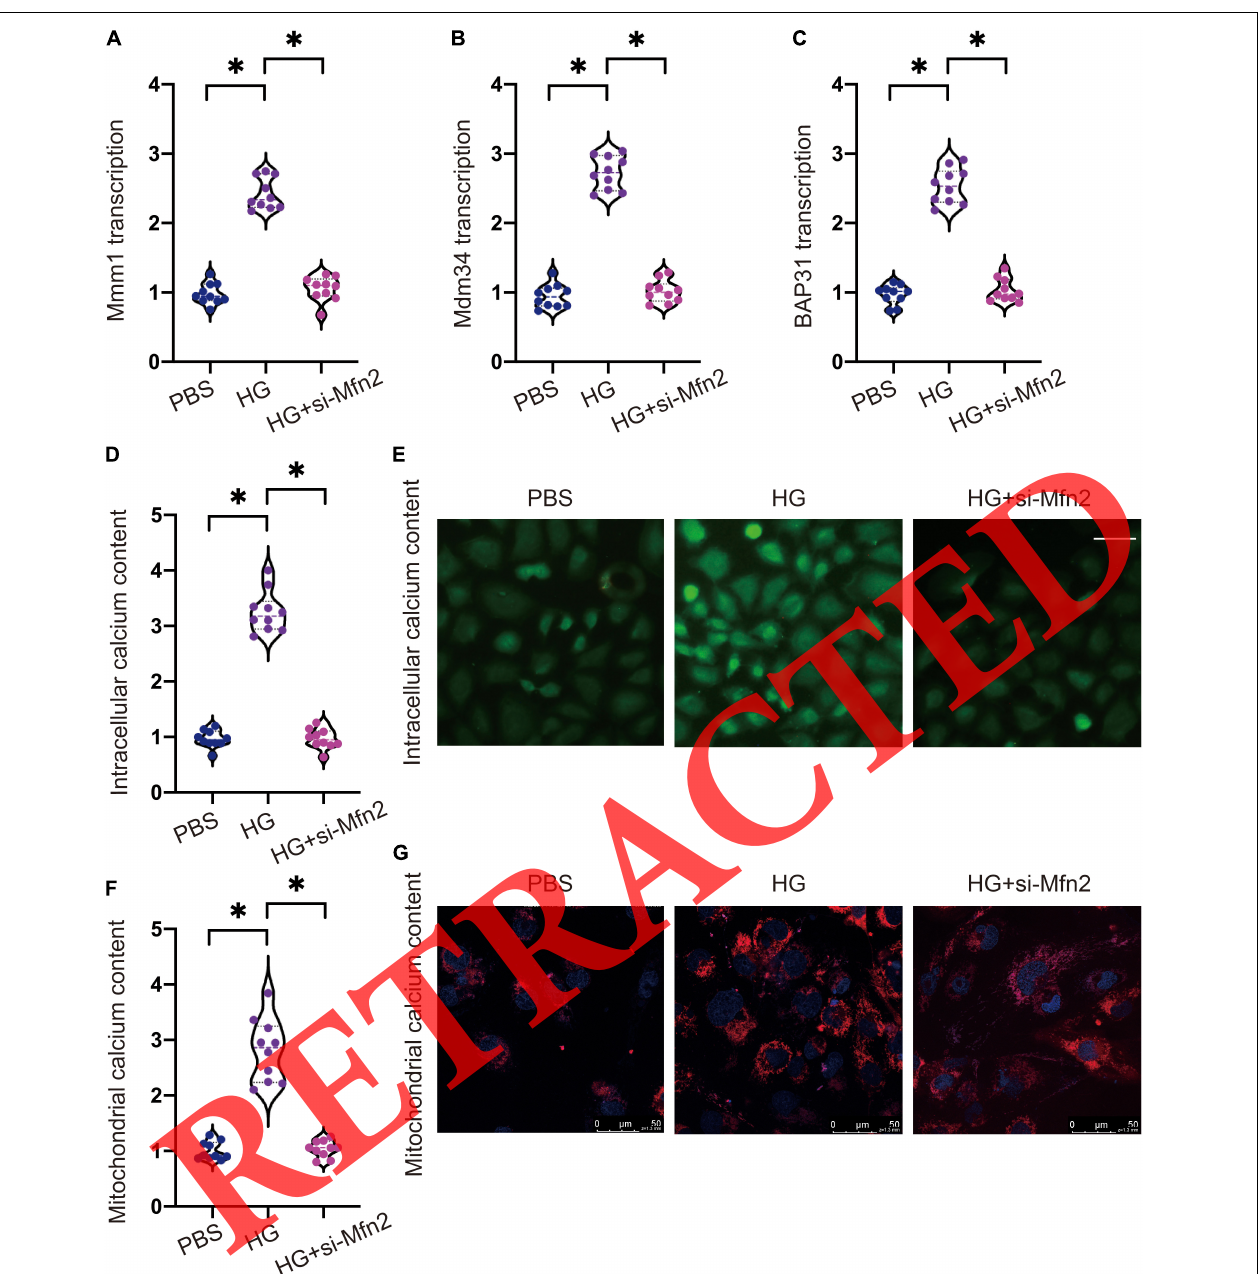
FIGURE 3 | Mfn2 promotes mitochondria–endoplasmic reticulum (ER) contact and induces calcium release from the ER to the mitochondria in cardiomyocytes. (A–C) Western blot was used to analyze the expressions of mitochondria–ER contact markers, including Mmm1, Mdm34, and BAP31. (D–G) Immunofluorescence was used to detect the calcium levels in the ER and the mitochondria. ∗ p <